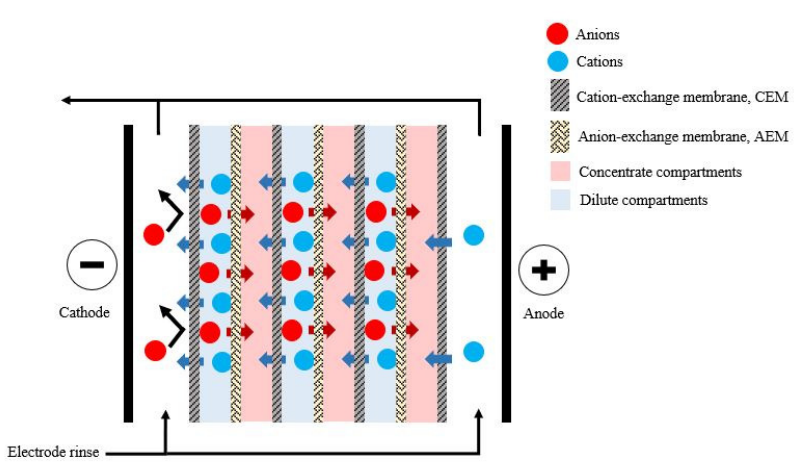
Figure 3. Schematic representation of